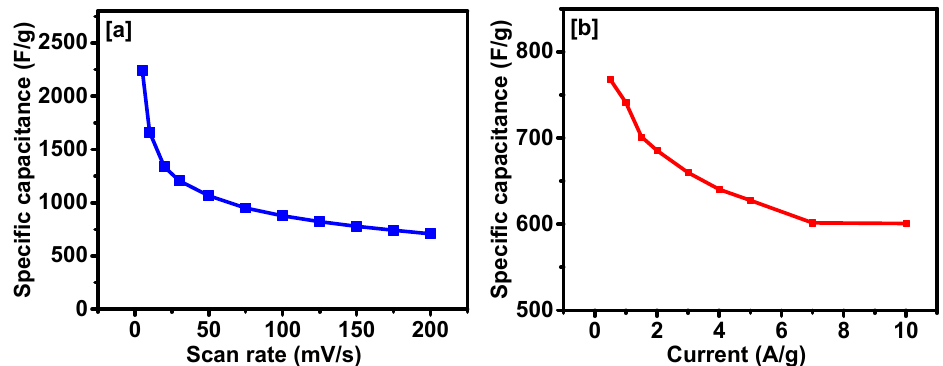
Figure 7. Variation of specific capacitance as a function of ( a ) scan rate and ( b ) current density for FeCo 2 O 4 ED @ Ni-foam.